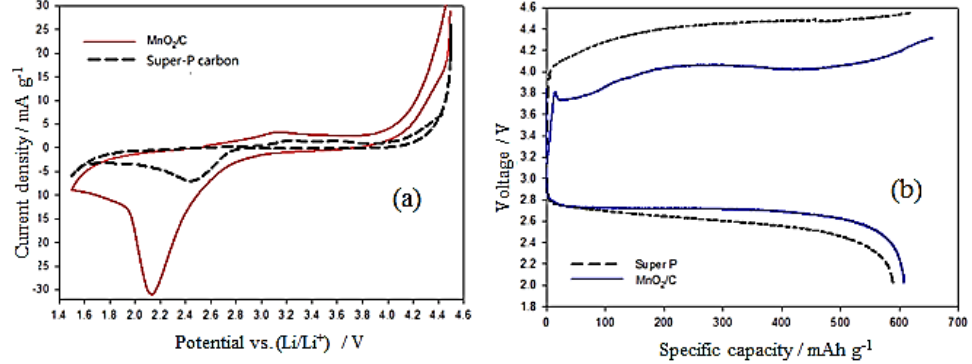
Figure 5. ( a ) CV curves were recorded at a scanning rate of 2 mV·s − 1 for MnO 2 /C and Super-P carbon samples; ( b ) initial charge–discharge profiles for MnO 2 /C and Super P samples at a current density of